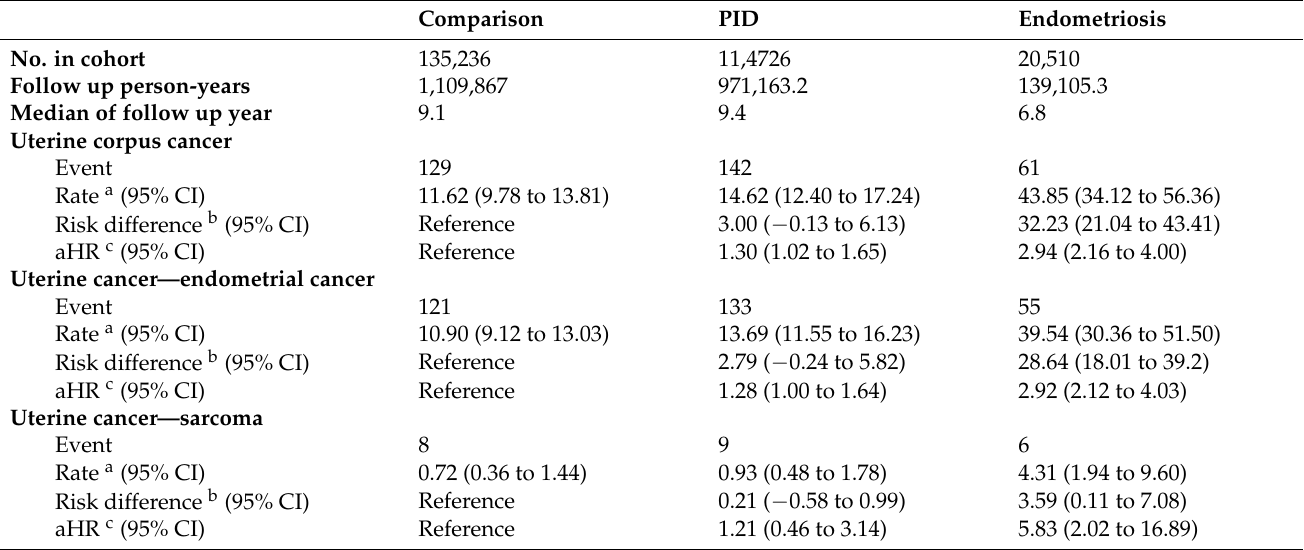
Table 2. Incidence rate of uterine corpus cancer between exposure (pelvic inflammatory disease or endometriosis) and comparison cohorts.